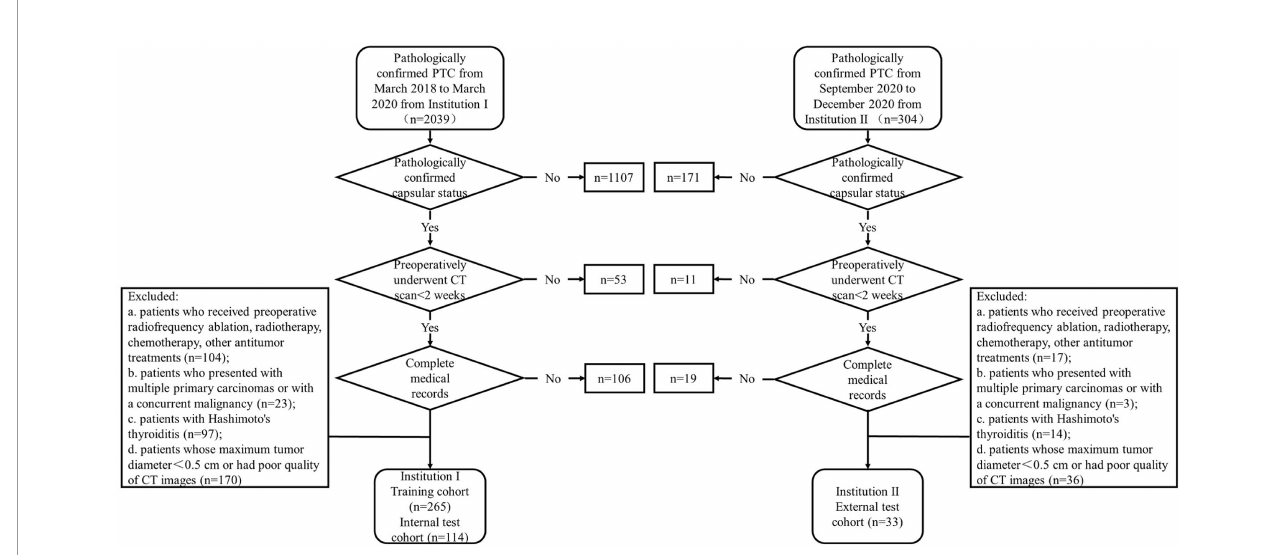
FIGURE 1 | The patient recruitment pathway in the two-center